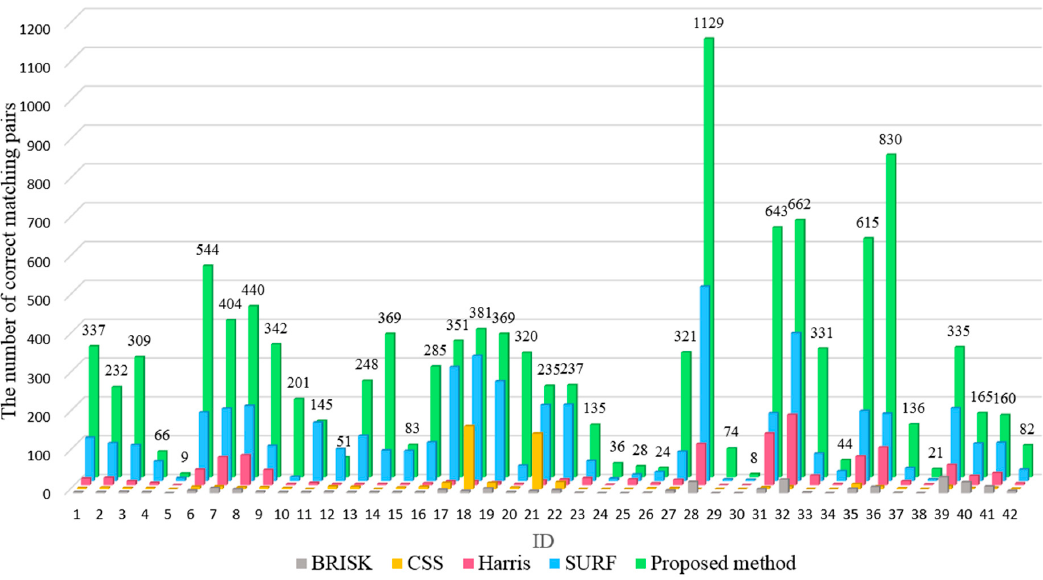
Figure 15. Comparison of the numbers of the correct matching pairs from the state-of-the-art methods and the proposed method.